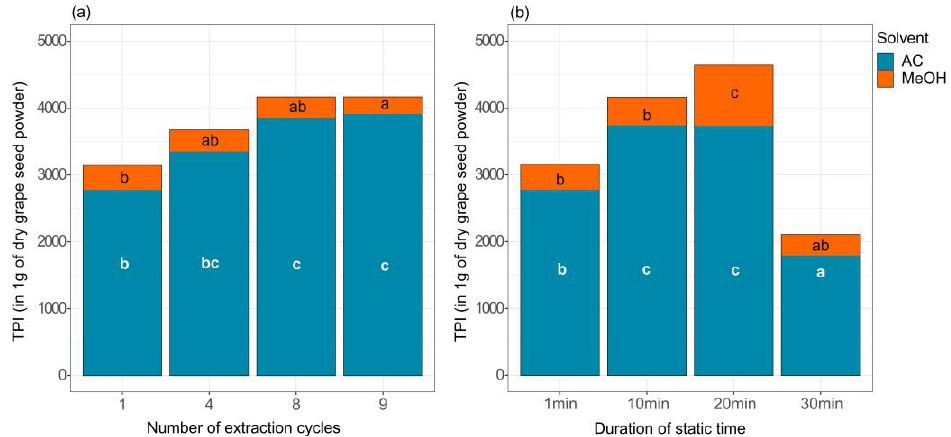
Figure 2. Total phenolic index (TPI) in 1 g of lyophilised grape seed powder extracted with accelerated solvent extraction with 80% aqueous acetone (AC) and 60% aqueous methanol (MeOH). ( a ) TPI with different numbers of ECs ( n = 3), ( b ) TPI with different STs ( n = 3). Different letters indicate statistically significant differences between TPI within each solvent used (ANOVA, p < 0.05).